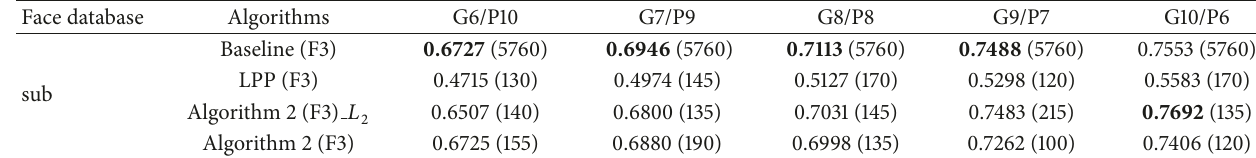
Table 22: The recognition rates on sub Extended Yale B face database over “F3” features; recognition rates (dimensionality).